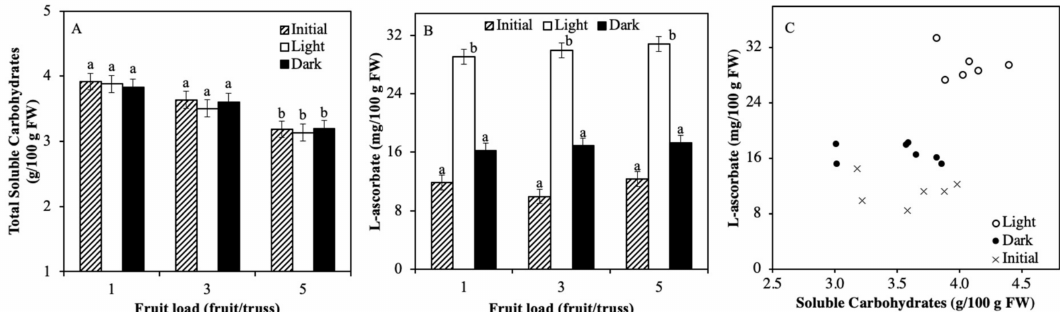
Figure 4. Relation between fruit carbohydrate and ASC levels in mature green and light or dark ripened tomato fruits that were grown at 3 di ff erent fruit load levels (1, 3, or 5 fruits per truss). Total soluble carbohydrate content (sum of sucrose, fructose, and glucose ( A ) and ASC levels ( B )) before and after ripening in light 300 µ mol m − 2 s − 1 or darkness for 7 days. Correlation between ASC and carbohydrate content of individual samples ( C ). Each data point is based on pooled sample of pericarp discs of 2 fruits. Error bars represent standard errors of means, letters indicate statistical di ff erence at α = 0.01; n = 5; Experiment 3).